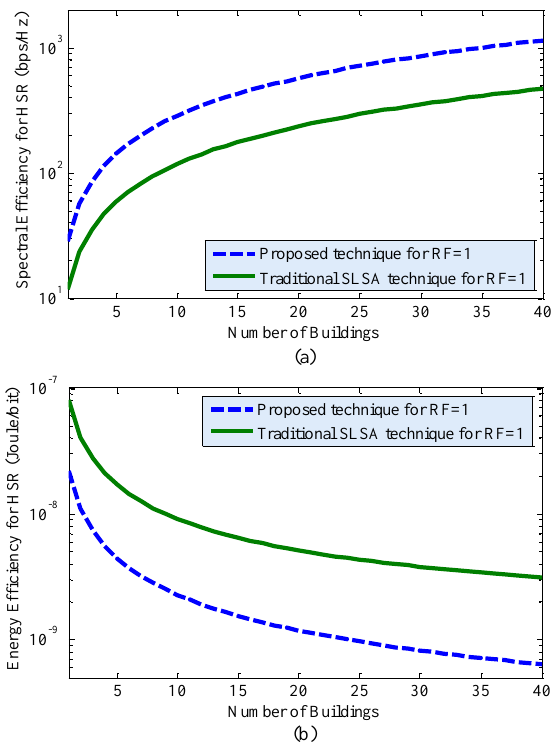
Figure 4. Performance of the proposed technique and the traditional SLSA technique due to the variation in horizontal spatial reuse (HSR) between adjacent buildings of small cells in terms of SE and EE for RF = 1: ( a ) SE performance and ( b ) EE performance.